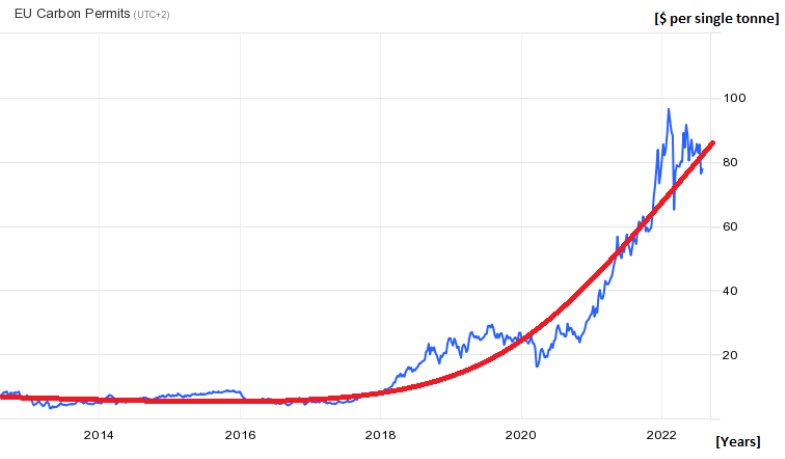
Figure 14. CO 2 emissions permits price in last decade.